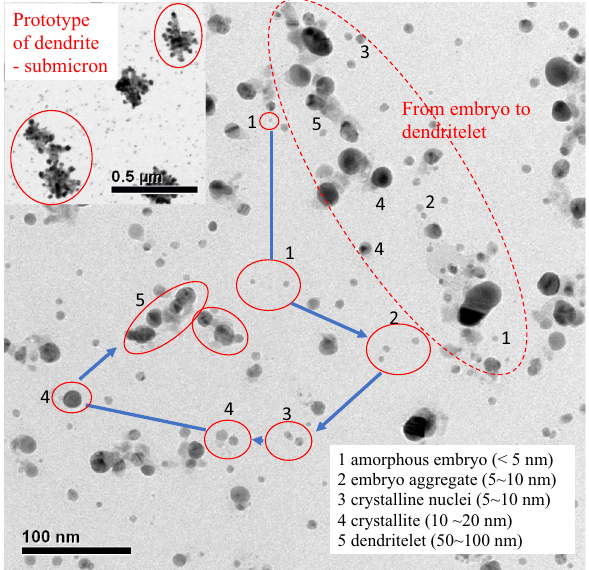
Figure 2. The sampled electrolytic products reveal the history or mechanism of the dendrite formation. The silver ions produced from the anode wire due to the electrolytic potential were reduced to silver atoms at the cathodic wire. The silver atoms aggregated to form amorphous embryos, where 1 had a diameter of less than 5 nm. The nano embryos approached each other to form the embryo aggregates, where 2 had diameters of 5–10 nm. The embryos and the embryo aggregate further coalesced and transformed into crystalline nuclei, where 3 had a diameter ranging from 5 to 10 nm. The crystalline nuclei when nourished by embryos, embryo aggregates, and nuclei grew into crystallites, 4 with a diameter of 10–20 nm. The crystallites exhibited a lattice orientation and thus became fully dark upon growth. The agglomeration of crystallites tended to reorient them to shape the dendritelets, where 5 had a diameter of 50–100 nm. The broken helical circle is a summary of the collection, which further demonstrates the stepwise progress from amorphous embryos (1) to the ultimate dendritelets (5). The aggregation of the dendritelets gave rise to the formation of the dendrite prototype, as shown in the